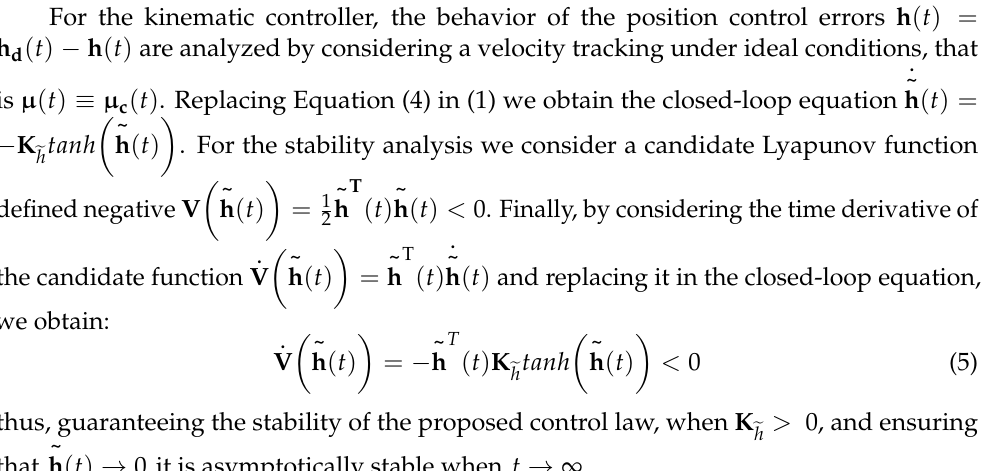
Figure 6. Proposed control scheme.